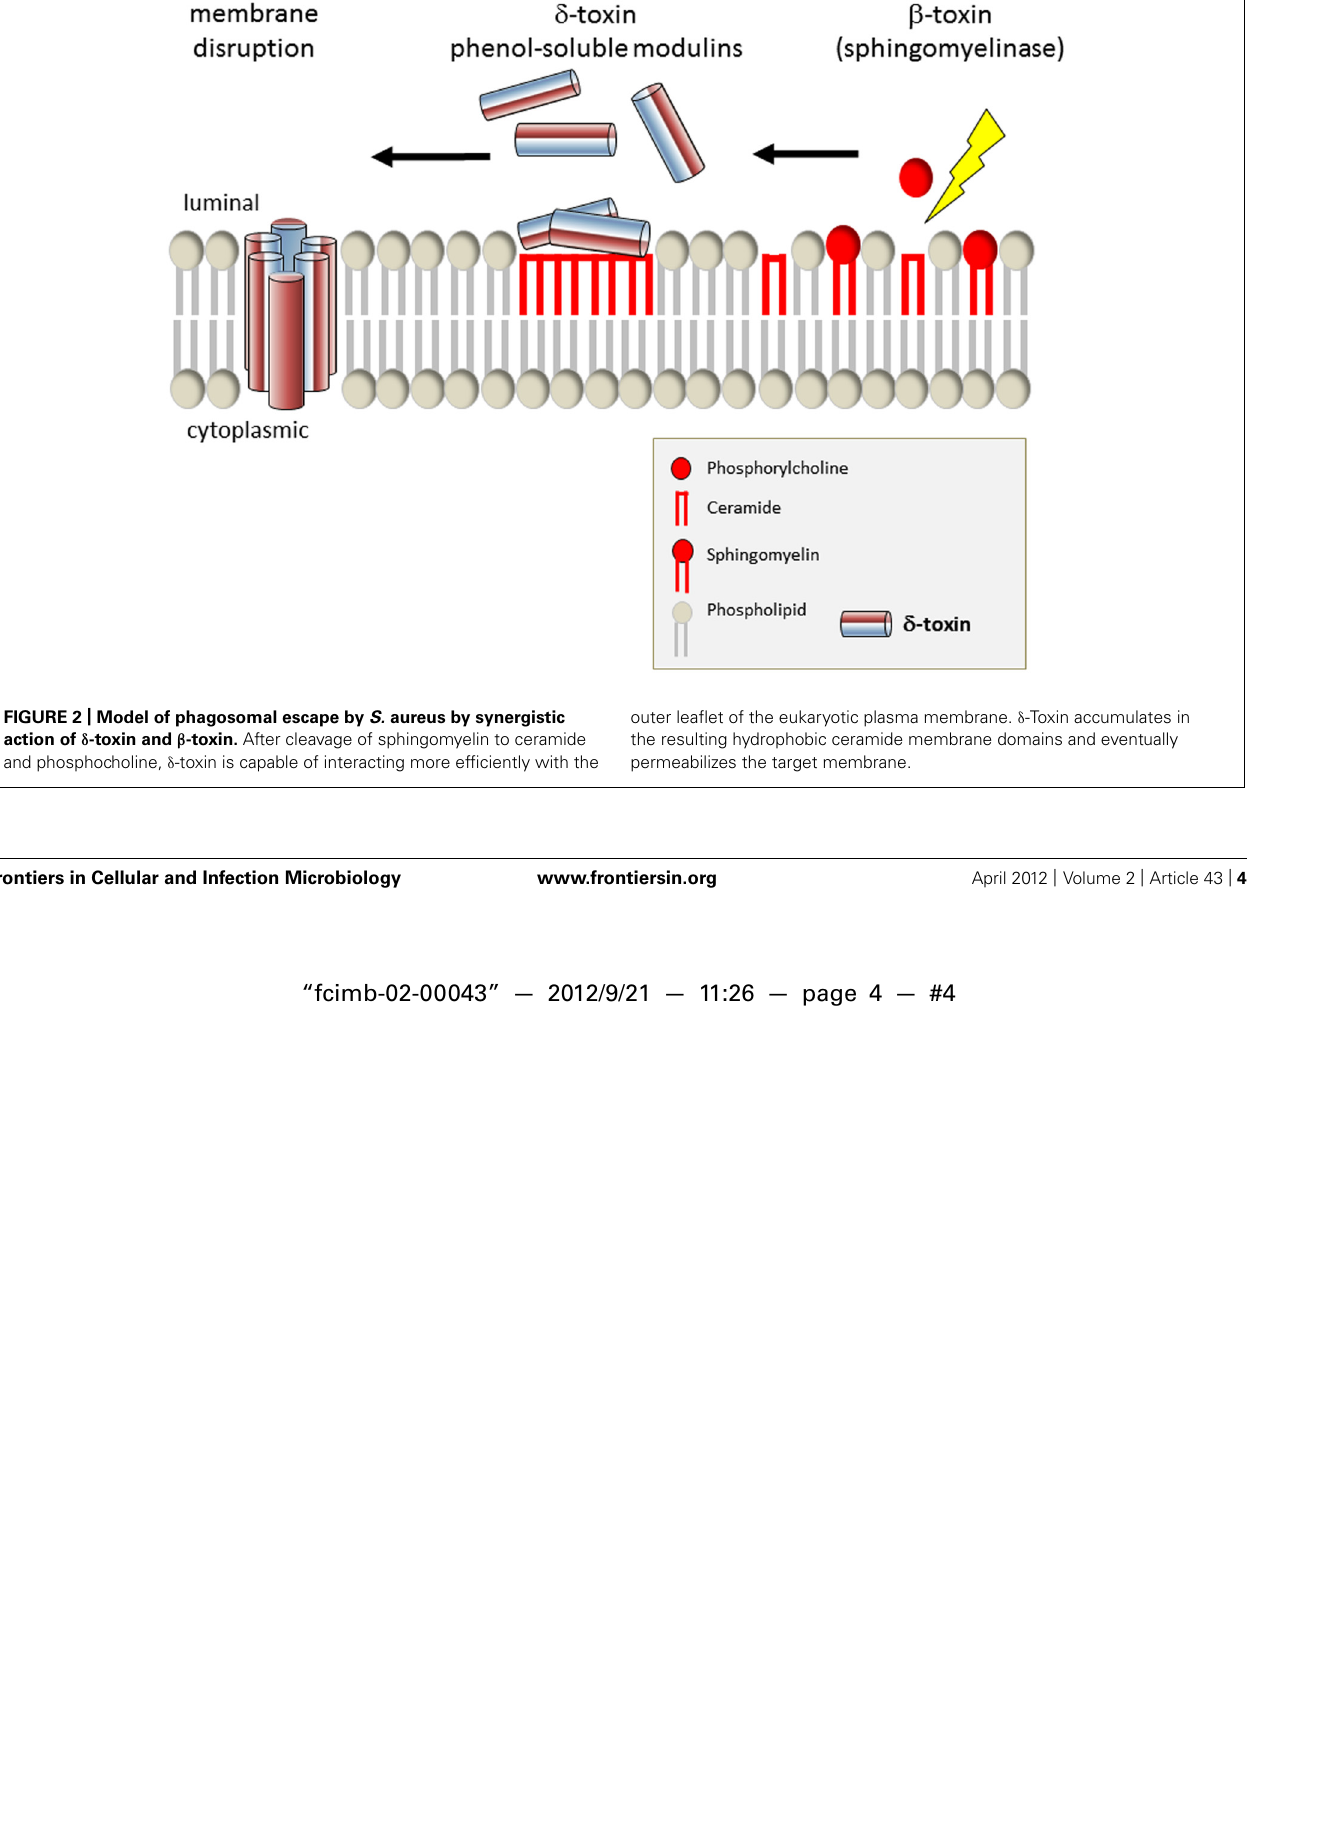
outer leaflet of the eukaryotic plasma membrane. δ -Toxin accumulates in the resulting hydrophobic ceramide membrane domains and eventually permeabilizes the target